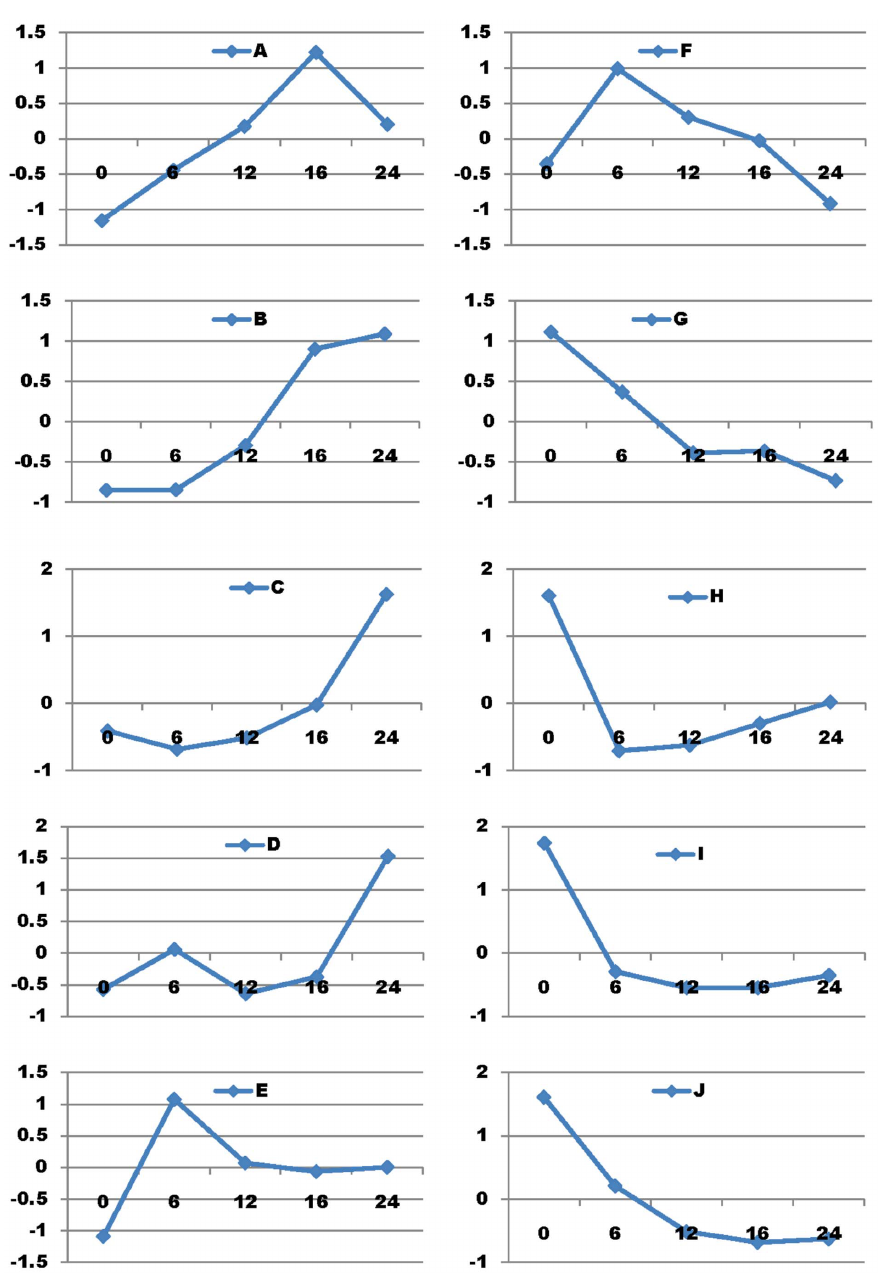
Figure 5. Ten expression trend clusters of 699 DE genes derived from PAMs during PRRSV infection.